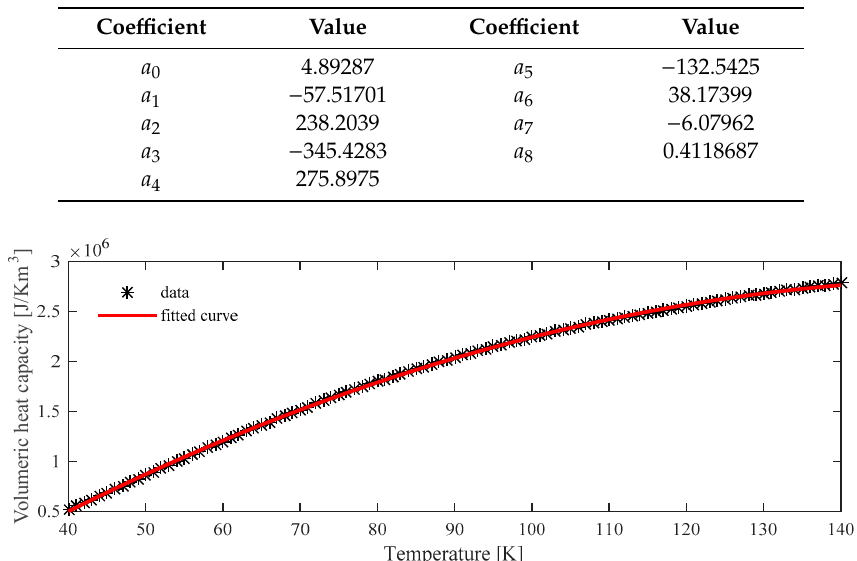
Figure 5. Compared results between the uses of the eighth-order interpolating polynomial and quadratic form.